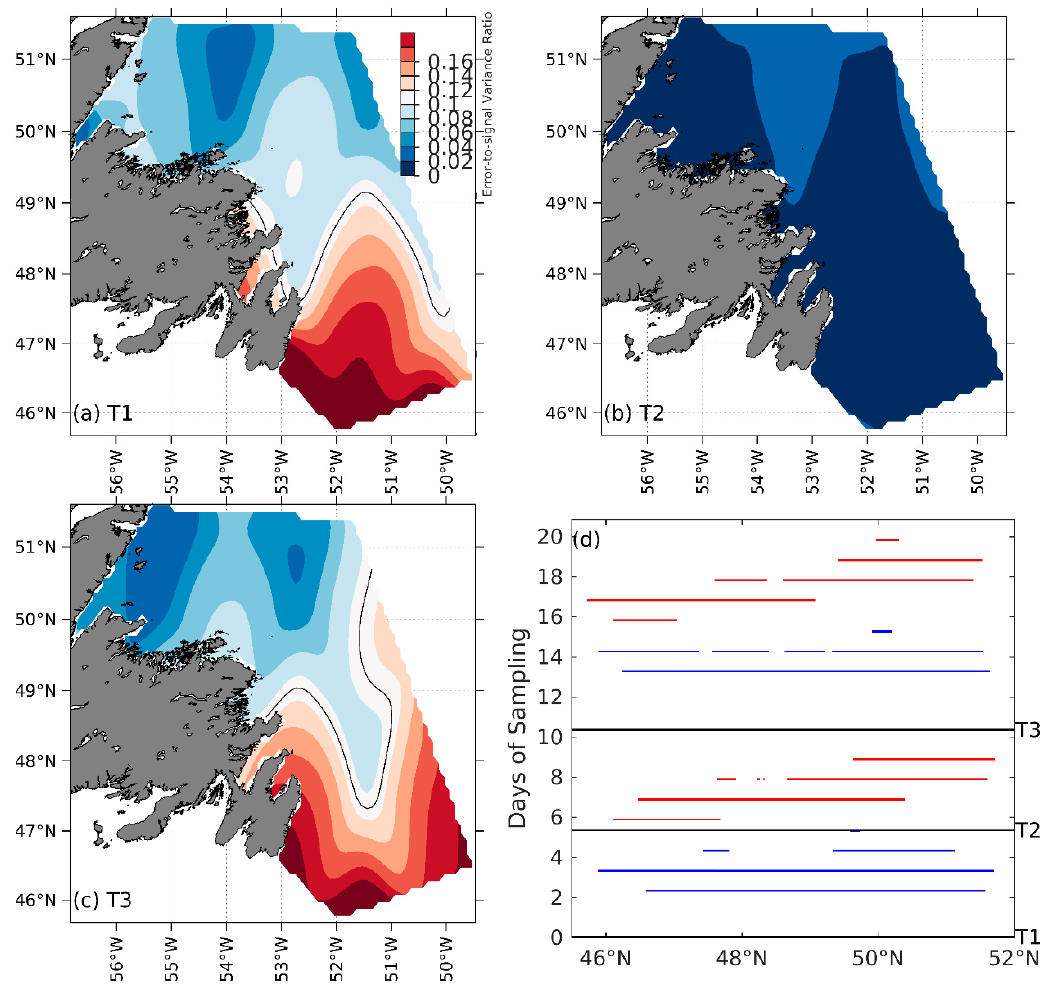
Figure 10. Residual variance ratio at ( a ) T1, ( b ) T2, and ( c ) T3 indicated as black lines in ( d ) ascending swath passes (red lines) and descending swath passes (blue lines) inside the region as a function of time and latitude. Black contours from ( a )–( c ) are the boundary lines of 0.11.